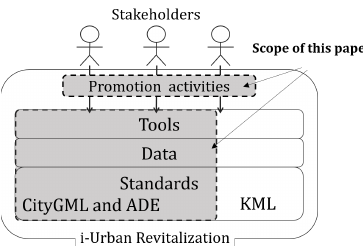
Figure 1. The structure of i-Urban